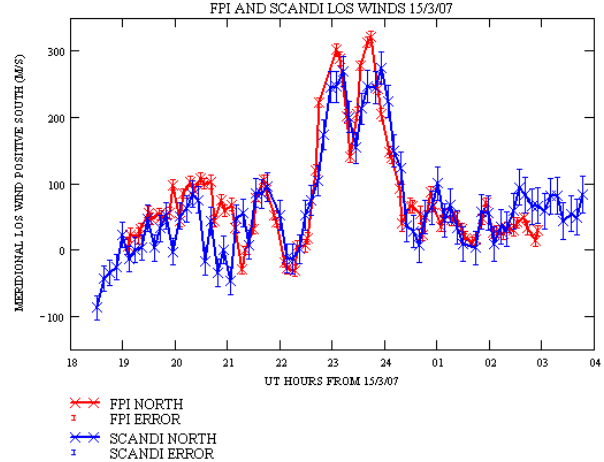
Fig. 2. A close correspondence shown between SCANDI (zone 15) and FPI LOS Winds looking north from the night of 15 March 2007. FPI LOS winds are systematically larger owing to a much smaller field-of-view. Winds are positive